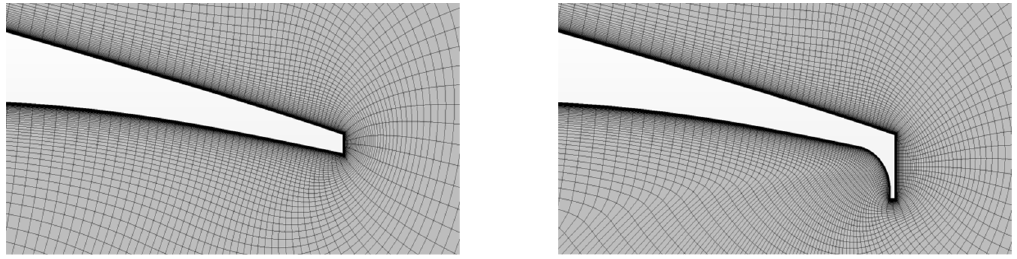
Figure 1. Mesh distribution on the trailing edge; with the clean airfoil and with a GF of 1.5% c implemented.